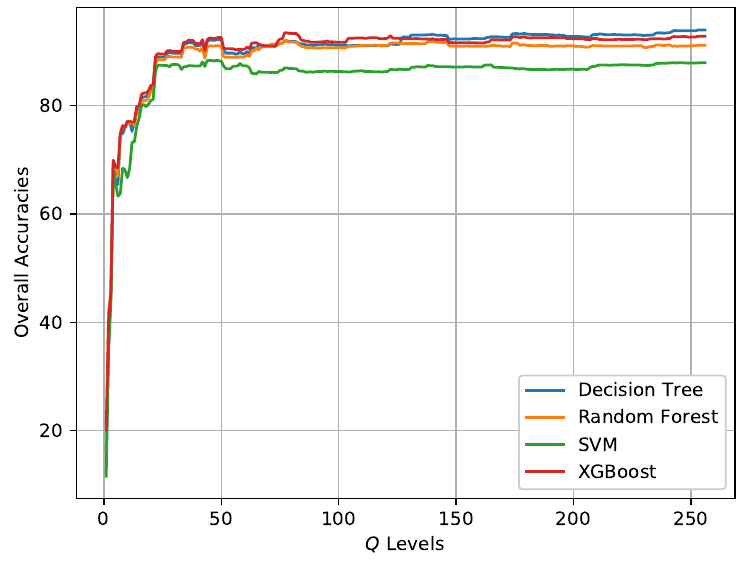
Figure 20. Classification results of different Q levels in SRM for AIRSAR Flevoland data set.